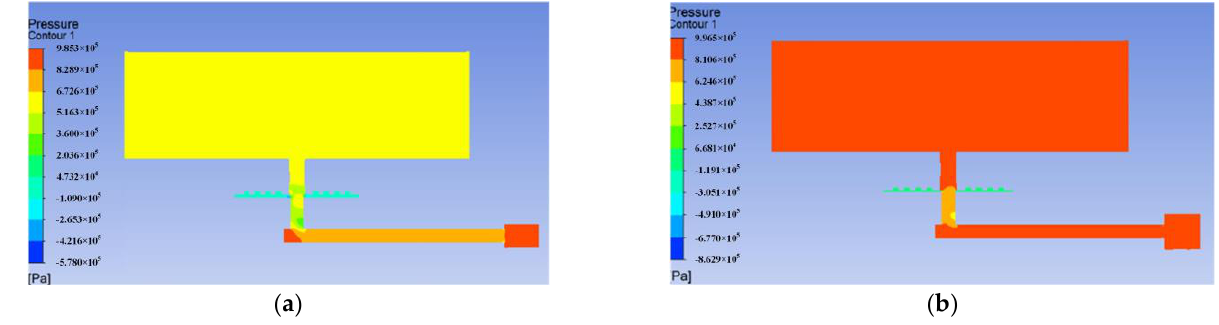
Figure 10. Influence of two sections of the inlet pipe on the gs driving force. ( a ) Inlet pipe circular section. ( b ) Inlet pipe oval section. Table 1. Variation of gas driving force with intake tube cross